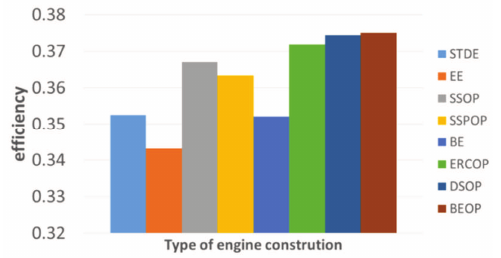
Fig. 17. Comparison of different engine configuration on efficiencies.